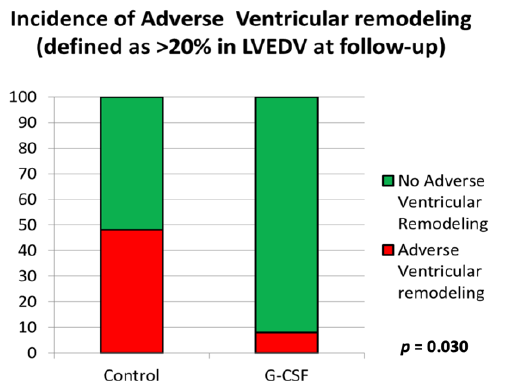
Figure 3. The incidence of adverse ventricular remodeling at 10-year follow-up in optimal control group versus G-CSF treatment group.